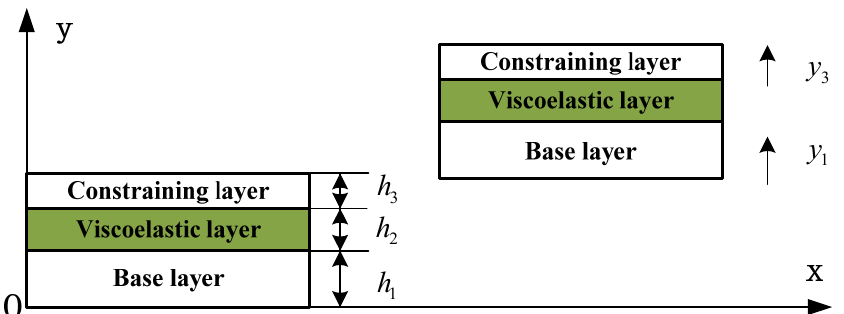
Figure 2. The geometric and deformation relationship of the EVES beam.